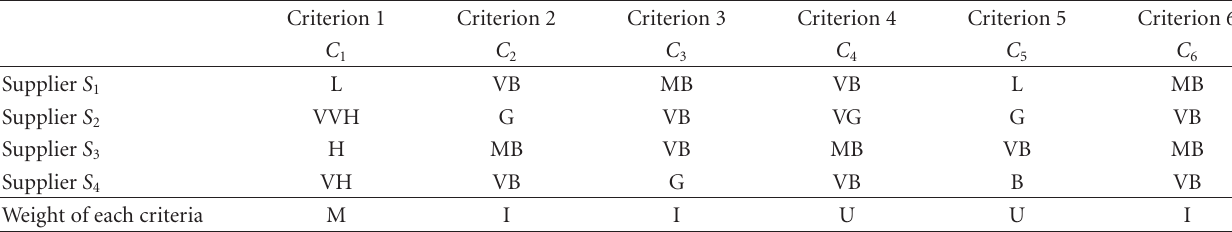
Table 8: Rating of the alternatives from decision maker 4 (DM 4